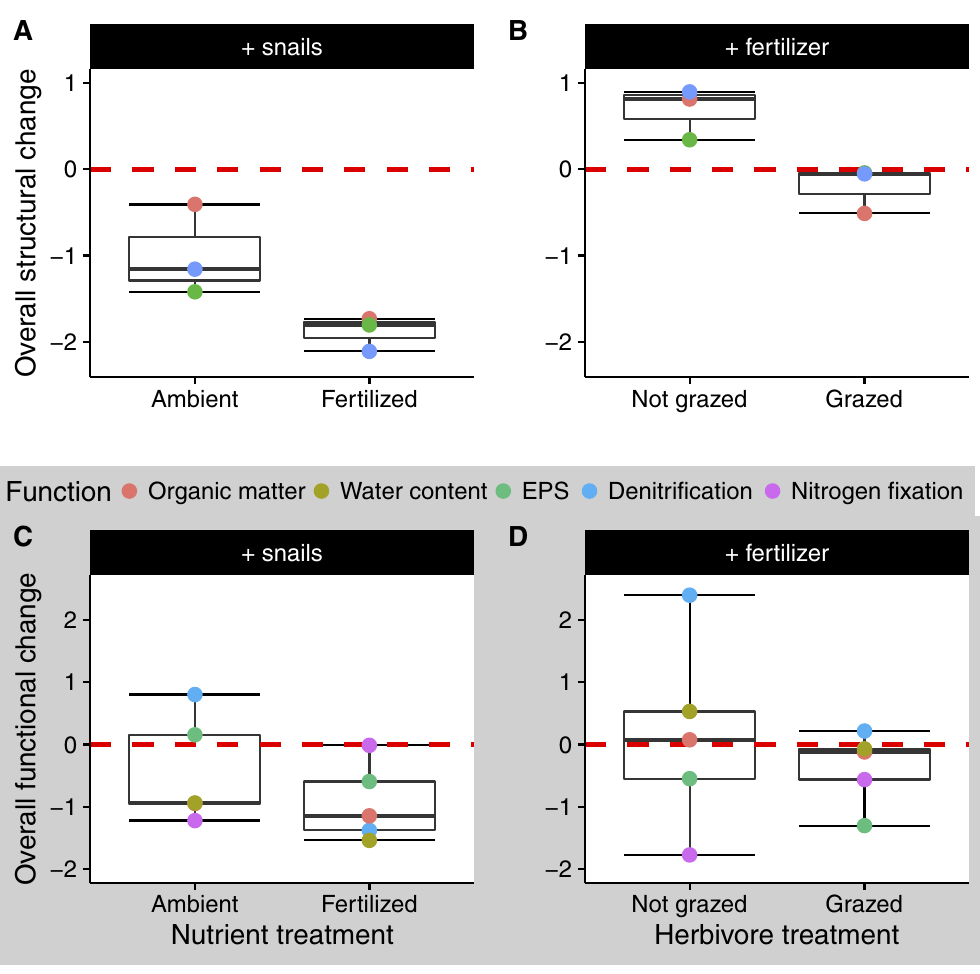
Figure 3. Overall structural ( A , B ) and functional ( C , D ) change in the different treatments. The dashed red line denotes the “no-change”